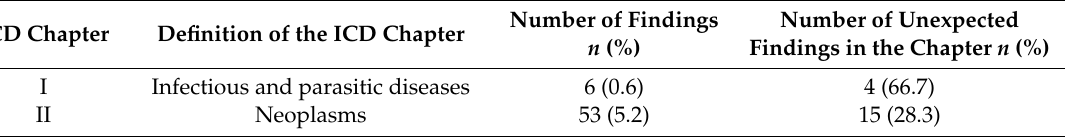
Table 1. An overview of all post-mortem computed tomography (PMCT) findings categorized in their corresponding International Classification of Diseases (ICD) chapter. Chapters V, VII, XV, XVI, XX, and XXI are not shown because no findings were reported for these chapters. The number of findings and the percentage of the total number of findings are presented. Additionally, the number of unexpected findings in the chapters is shown, and as a percentage of total findings in the corresponding chapter. For example, 22 PMCT findings that correlate with a disease in the nervous system were reported, which is 2.2% of the total number of PMCT findings in 120 decedents. Four of those 22 findings were unexpected, which is 18.2% of all findings of the nervous